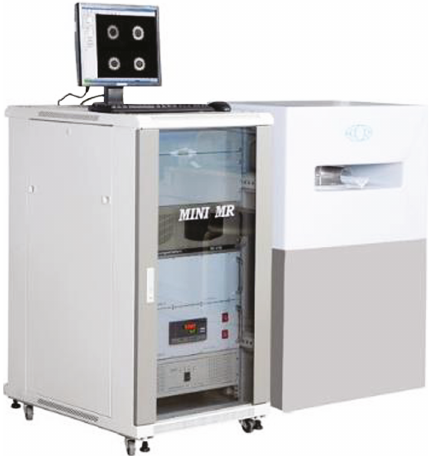
Figure 2: Low- fi eld nuclear magnet